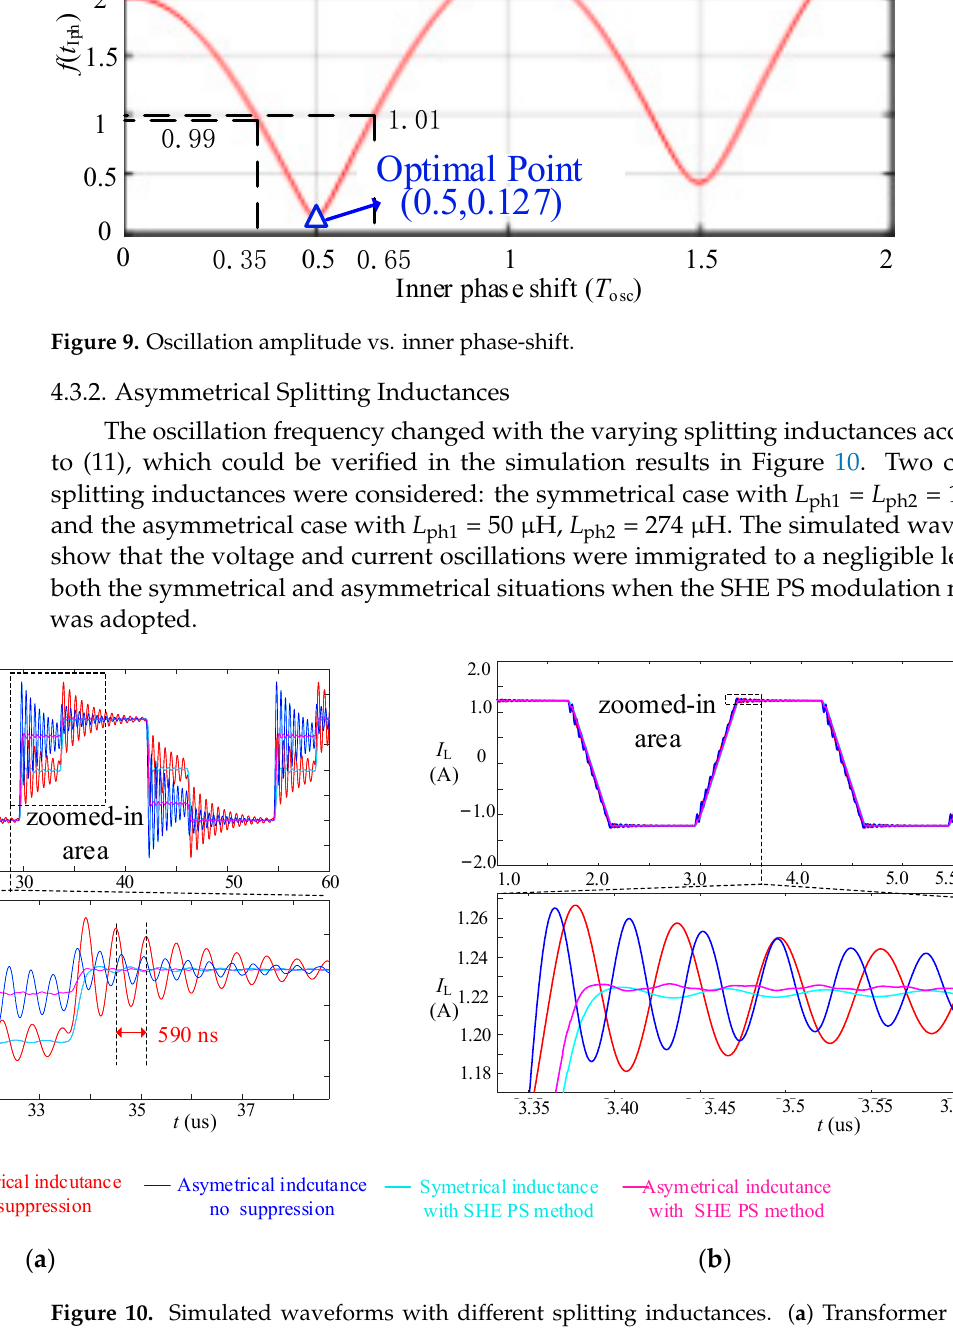
Figure 10. Simulated waveforms with different splitting inductances. ( a ) Transformer voltage; ( b ) transformer current.